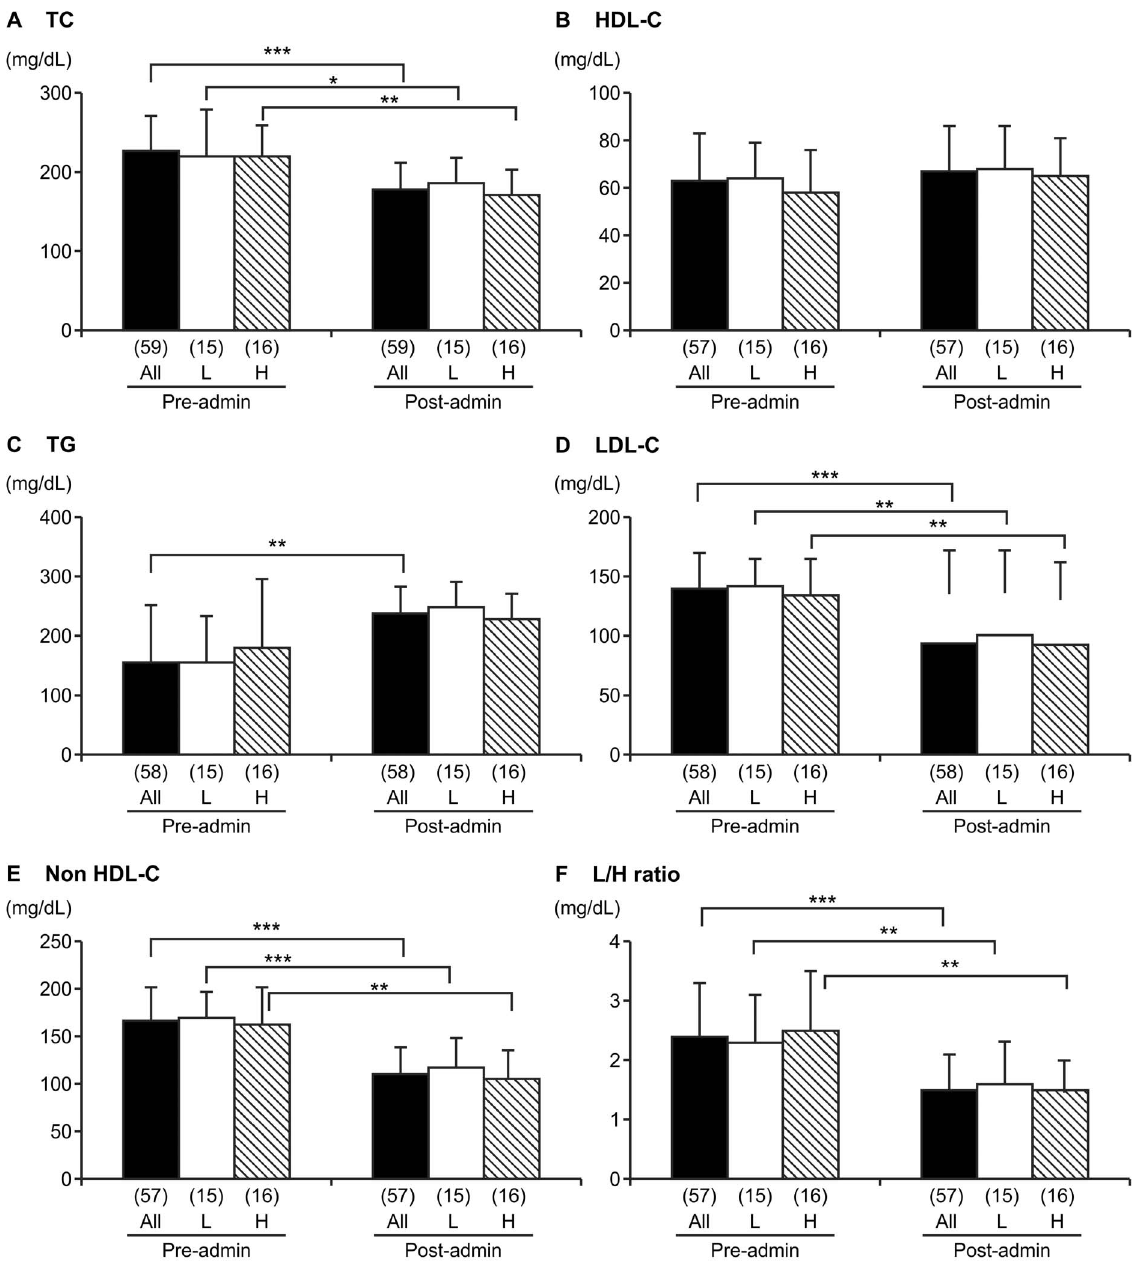
Figure 1. Lipid levels before and after pitavastatin treatment. The mean 6 standard deviation is presented. H indicates the group with homocysteine values above the median (8.6 m mol/L), L indicates the group with homocysteine values , 8.6 m mol/L. The number of subjects is indicated in parentheses. a) total cholesterol (TC), b) high-density lipoprotein cholesterol (HDL-C), c) triglyceride (TG), d) low-density lipoprotein cholesterol (LDL-C), e) non-HDL-C, and f) the L/H ratio. Pre- and post-pitavastatin values were compared as indicated by t-test or Wilcoxon signed- rank test (TG only). * p , 0.05, ** p , 0.01, *** p , 0.001.